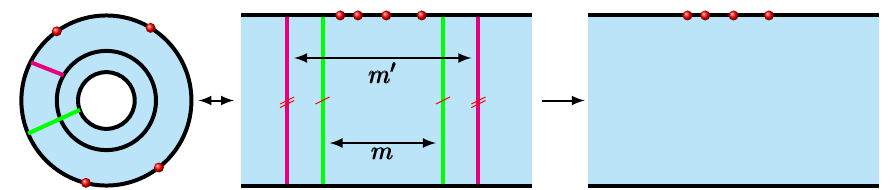
Figure 14 . On the left are shown two annuli with the same punctures but di(cid:11)erent moduli. They are equivalent to the strips with identi(cid:12)cations depicted in the middle, via the map (cid:27) ! exp i(cid:27) The strips both tend to the same surface as the moduli diverge, which is the in(cid:12)nite strip with punctures on the